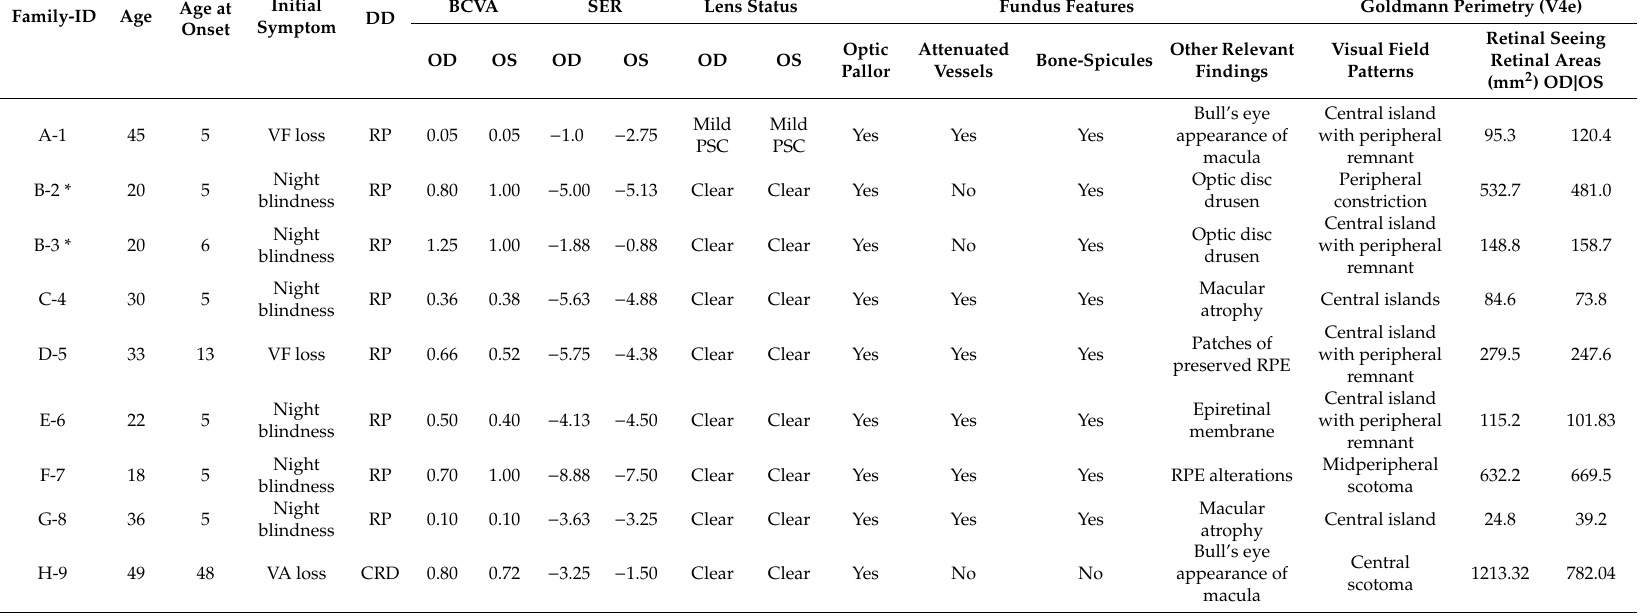
Table 1. Clinical characteristics of patients with RPGR -associated retinal dystrophies at the last